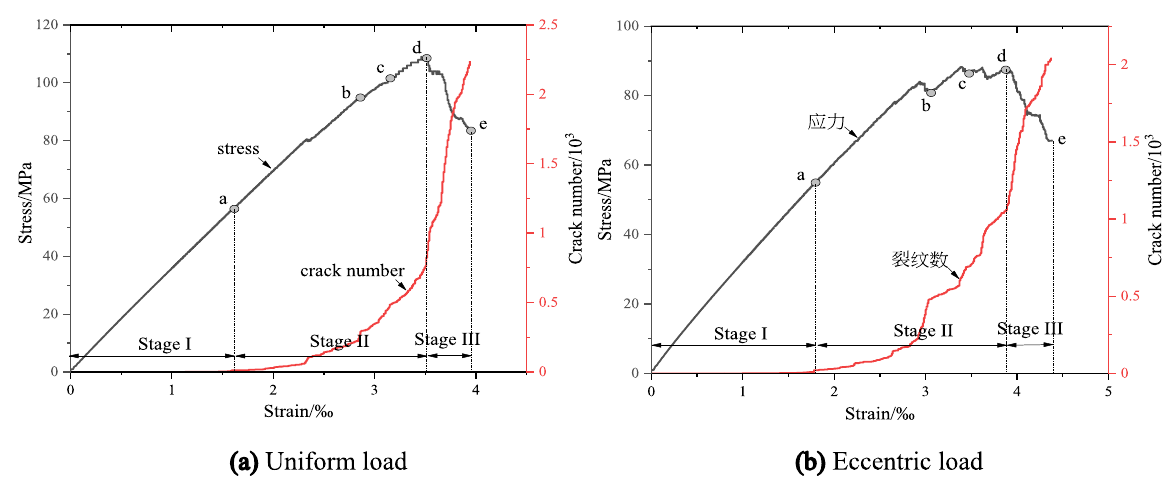
Figure 16. Relationship between crack number and stress–strain evolution under triaxial